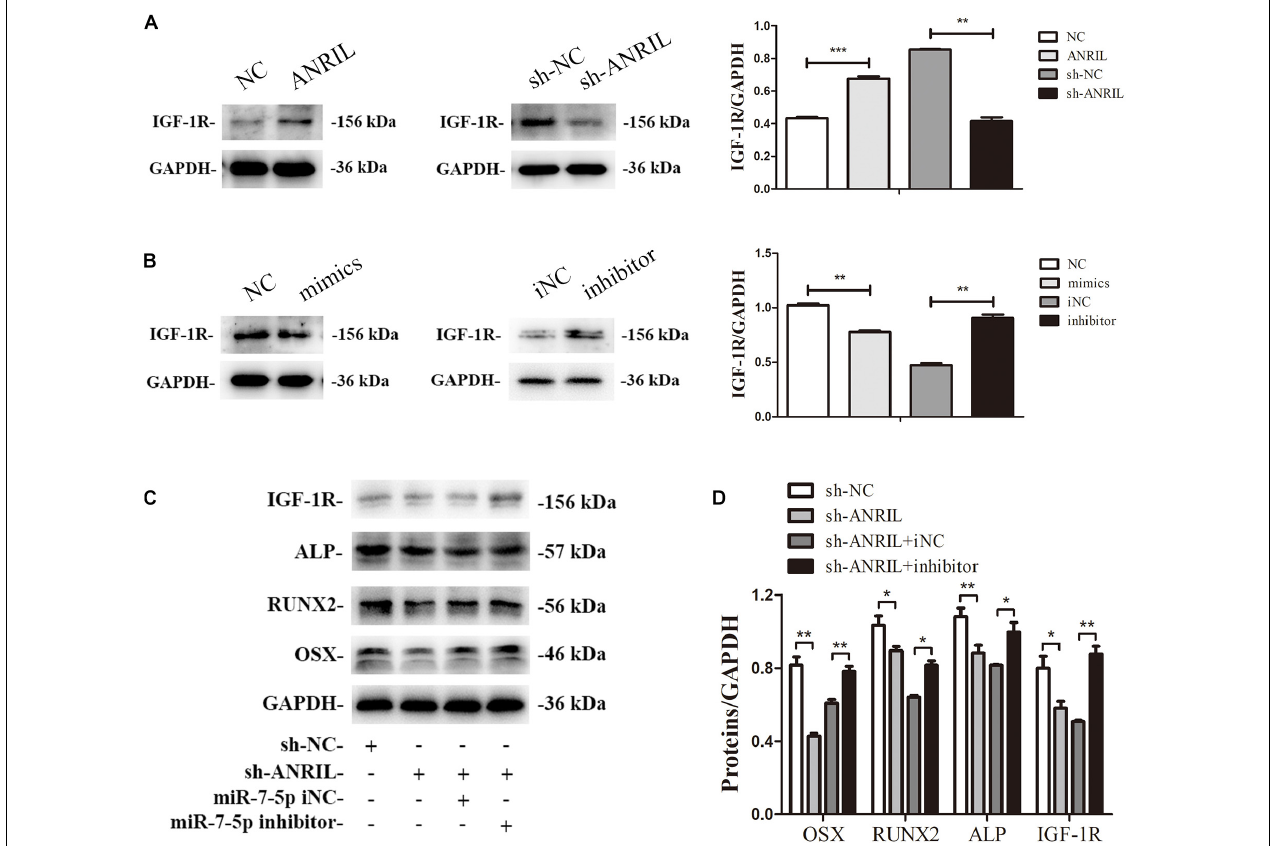
FIGURE 7 | MiR-7-5p inhibitor rescues the role of ANRIL knockdown on committed differentiation of iPDLSCs. (A) IGF-1R expression in iPDLSCs transfected with overexpression and low-expression ANRIL. (B) IGF-1R expression in iPDLSCs transfected with miR-7-5p mimics, mimics NC, miR-7-5p inhibitor and inhibitor NC. (C,D) Expression of IGF-1R/ IGF-1R , ALP/ ALP , RUNX2/ RUNX2, and OSX/ OSX in iPDLSCs co-transfected with lncRNA ANRIL and miR-7-5p (* P < 0.05, ** P < 0.01, *** P <